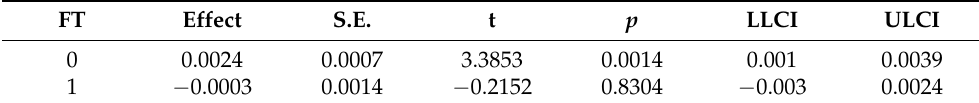
Figure 2. Graph of moderating effect of firm type on the relationship between CSR and profitability. Table 7. Conditional effects of the focal predictor at values of the moderator.